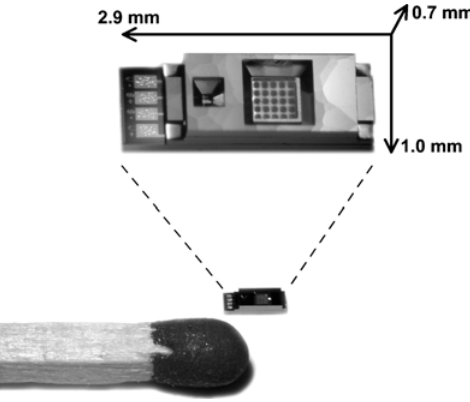
Figure 8. Microfabricated sensor based on the swelling of a pH sensitive hydrogel and used as a carbon dioxide sensor [115]. © 2005 Springer Science+Business Media,